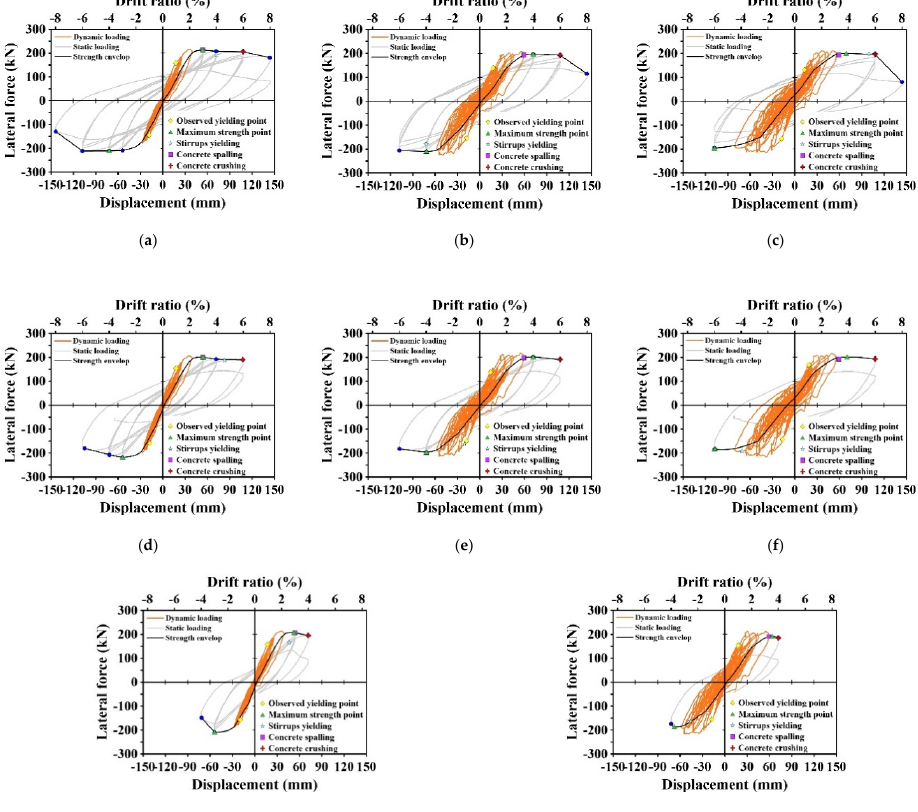
Figure 8. Relationship between lateral force and deformation of each specimen. ( a ) FF-15S-II; ( b ) FF-15S-III; ( c ) FF-15S-IV; ( d ) FSF-15S-II; ( e ) FSF-15S-III; ( f ) FSF-15S-IV; ( g ) SF-30S-II; ( h ) SF-30S-III.